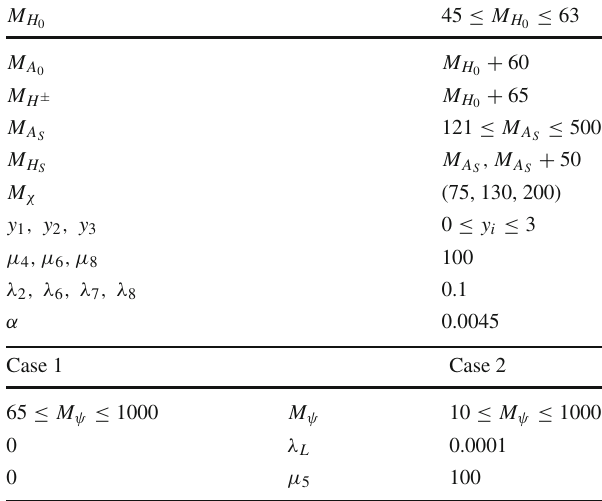
Table 1 Parameters considered for the DM relic density study in sce- nario 1. All mass parameters are in